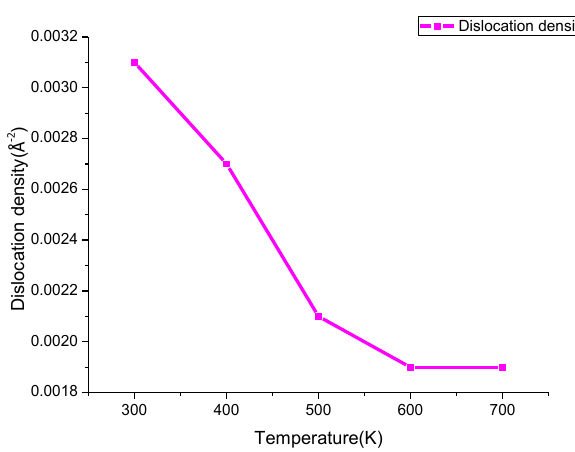
Figure 11. The trend of dislocation density during cooling in Case 1.